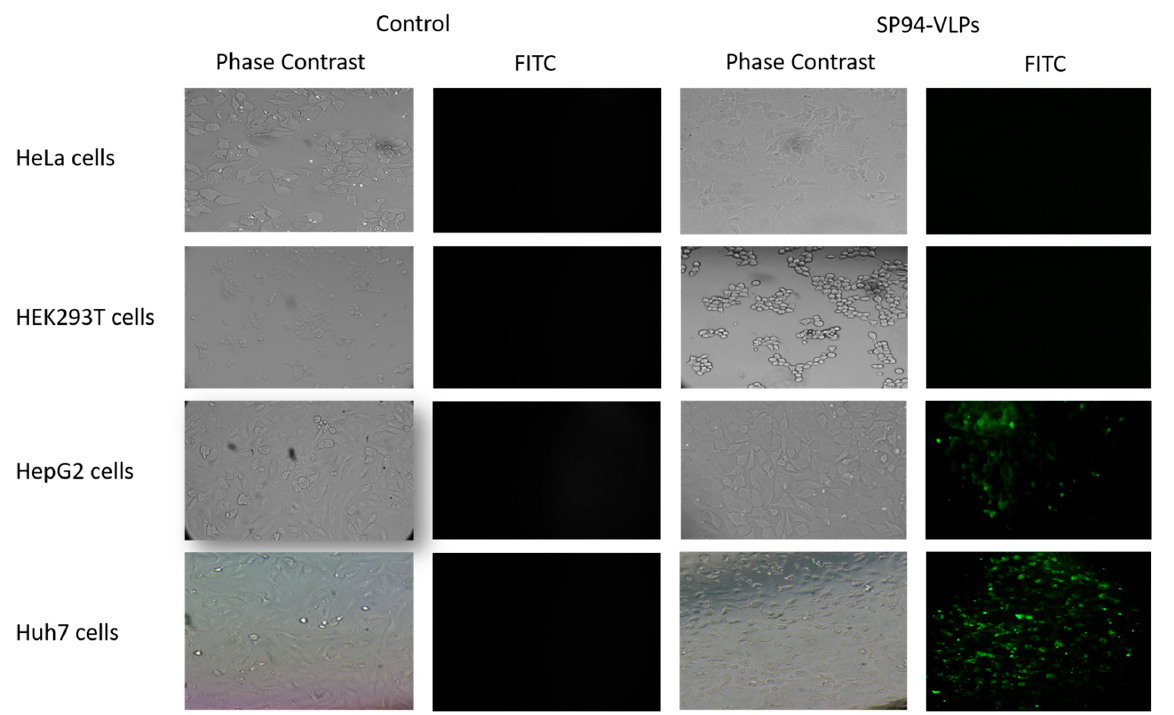
Figure 3. HeLa, HEK-293T, HepG2, and Huh7 cells treated with purified SP94-core protein at a concentration of 100 µM for 2 h, indicating the specificity only towards liver cancer (Huh7 and HepG2) compared to non-liver cells (HEK-293T and HeLa cells). Controls are cells not incubated with SP94-core. 3.4. Overexpression of Grp78 Increased Binding Efficiency of RGD-Core Protein to Cancer Cells To assess the role of Grp78 as a possible marker for targeting cancer cells and its role in the enhancement of RGD-core protein binding, Grp78-mCherry and tubulin-mCherry were overexpressed in HeLa cells and HepG2 cells and incubated with RGD-core protein for 2 h at a concentration of 100 µM. The results demonstrated a high binding affinity of RGD-core protein, corresponding to the dramatic increase in the green fluorescence inten- sity in both types of cancer cells transfected with Grp78-mCherry compared to cells that were transfected with tubulin-mCherry. (Figure 4).